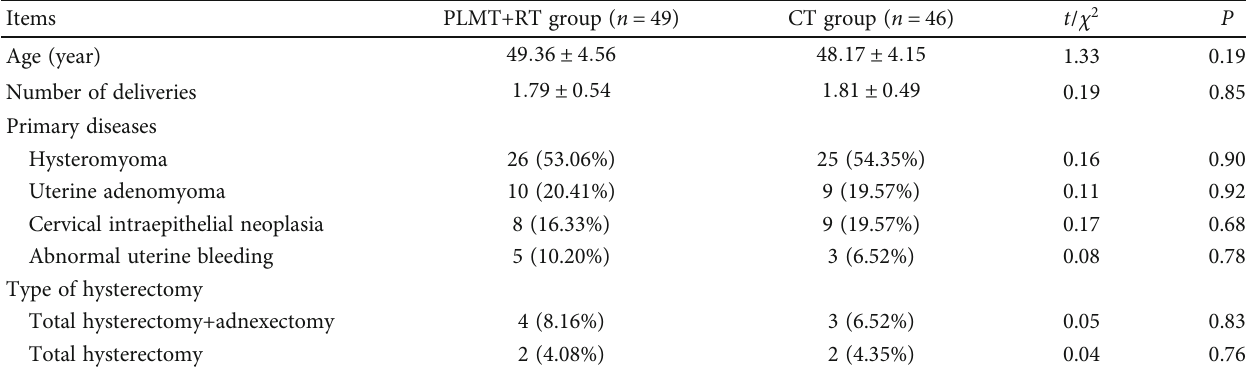
Table 1: General information of patients.